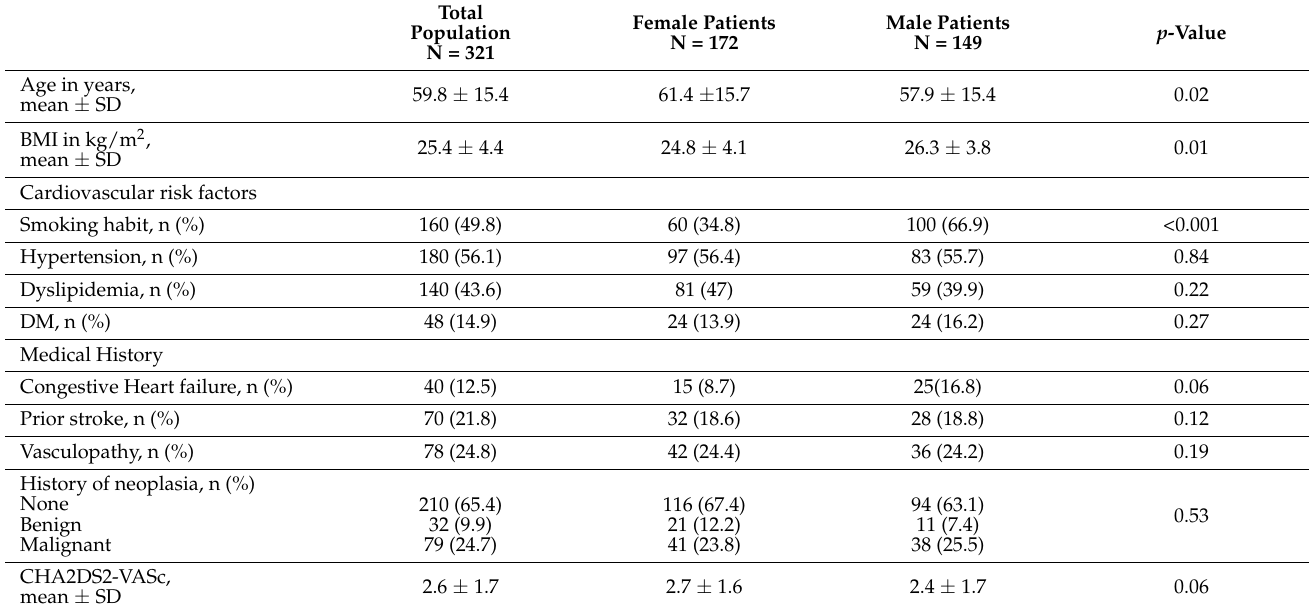
Table 1. Comparison of demographic and anamnestic features between female and male patients affected by cardiac masses.